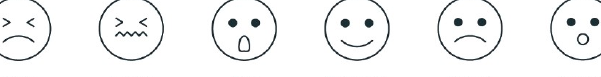
Figure 2. Six real basic facial expressions (collection two) [47]. Figure 3. Six real basic facial expressions (collection three) [48]. 4.3. Experimental Design The experiment was conducted over 2 days. All children—those with ASD and the typical children—had individual coaching sessions in two parts: assessment and training. The training session contained a preliminary guidance period that enabled both the children and caregivers to become aware of the system in order to have the chance to test the Facial Expressions Training Application (FETA). As soon as they were familiar with the FETA, the child and the caregiver had a separate period that enabled them to learn how to play the facial expression game. It should be noted that each of the participants, caregivers, and study employees had the chance to take a break and pause the game for any reason whatsoever, such as for bathroom and food breaks or due to a behavioral change or a lack of application endurance. Throughout the interference, further external auditory and video observation was in place. The procedure of the experiment is illus ‐ trated in Figure 4.